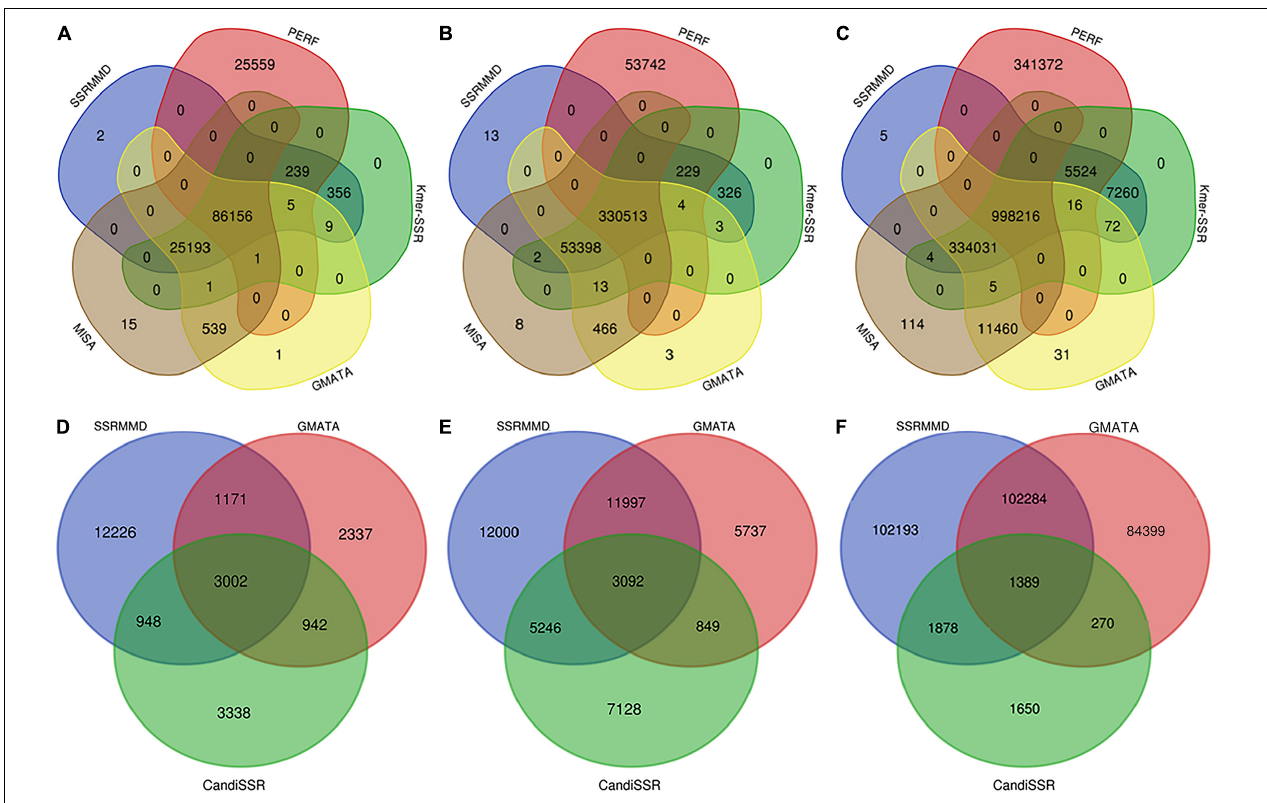
FIGURE 3 | Overlapping simple sequence repeats (SSRs) calculated by five programs [Simple Sequence Repeat Molecular Marker Developer (SSRMMD), PERF, Kmer-SSR, GMATA, and MISA], and overlapping polymorphic SSRs calculated by three programs (SSRMMD, GMATA, and CandiSSR). If the sequence name, start, and end position were the same in all programs, the SSR was considered overlapping. (A) Rice. (B) Cotton. (C) Wheat. (D) Rice. (E) Cotton. (F) Wheat. Notably, CandiSSR only mined 5,187 polymorphic SSRs of wheat chromosome